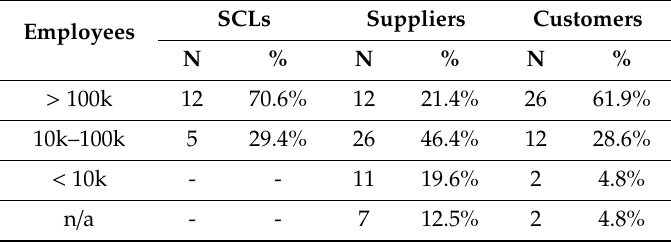
Table A6. Distribution of central sample firms per employee